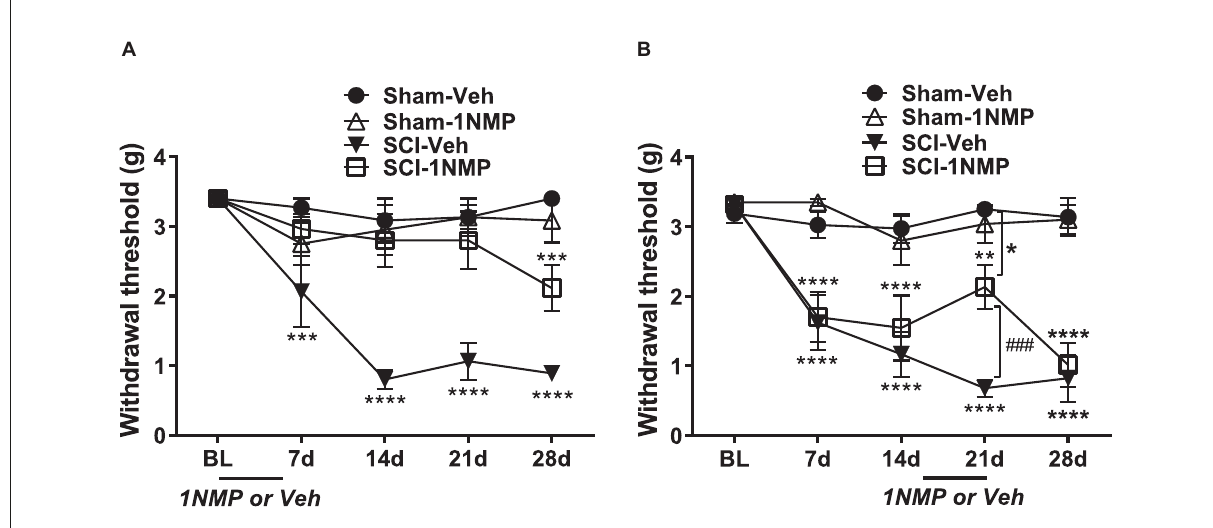
FIGURE3 TrkB inhibition attenuates hind-paw hypersensitivity after SCI. (A) Early administration of 1NMP (days 0–5) after SCI (open squares) blocked the development of mechanical hypersensitivity seen in SCI-Veh mice (filled triangles) which developed significant mechanical hypersensitivity at all timepoints (7–28 dpo) after SCI compared to their pre-surgery baselines (*** p < 0.001, and **** p < 0.0001). Only at 28 dpo did SCI-1NMP mice show a decrease in withdrawal threshold compared to baseline (*** p < 0.001). However, even then, their average withdrawal threshold was significantly greater than that of the vehicle-treated counterparts at 28 dpo ( p < 0.01, not indicated on graph). There were no differences in the withdrawal thresholds of either Sham group across treatment days. (B) Both SCI “late treatment” groups developed mechanical hypersensitivity over time compared to baseline withdrawal thresholds (** p < 0.01 and **** p < 0.0001). Treatment with 1NMP at 16–21 days after SCI (open squares), reversibly attenuated mechanical hypersensitivity at 21 dpo [withdrawal thresholds: significantly higher than SCI-Veh ( ### p < 0.001); although significantly lower than the Sham-Veh group (* p = 0.05)]. At 28 dpo, mechanical thresholds of SCI-1NMP mice had returned to those seen at 7 and 14 dpo, and were indistinguishable from SCI-Veh treated mice (filled triangles). SCI-Veh mice displayed hind-paw hypersensitivity at all time points, compared to their pre-surgery baselines. Sham mice did not show differences in withdrawal threshold across